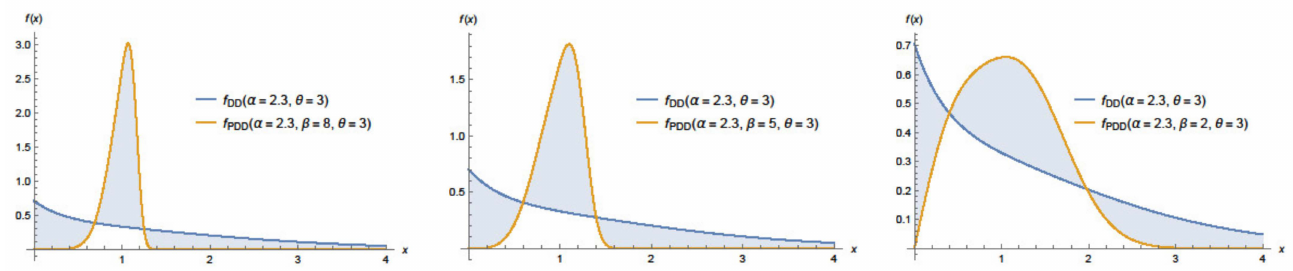
Figure 3. Plots of the PDD and DD with various values of parameters.